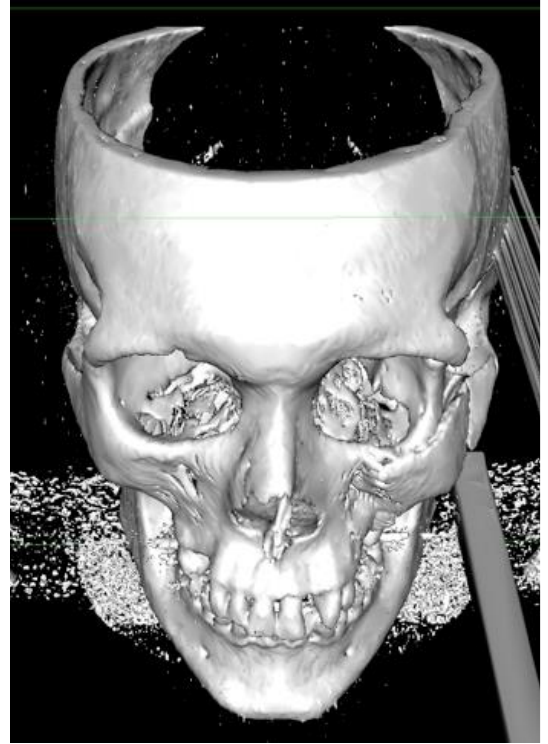
Figure 4. A frontal view on reconstruction from a 3D-CT trauma scan of the major cranio-facial fractures on the left orbital and zygomatico-malar complex area.